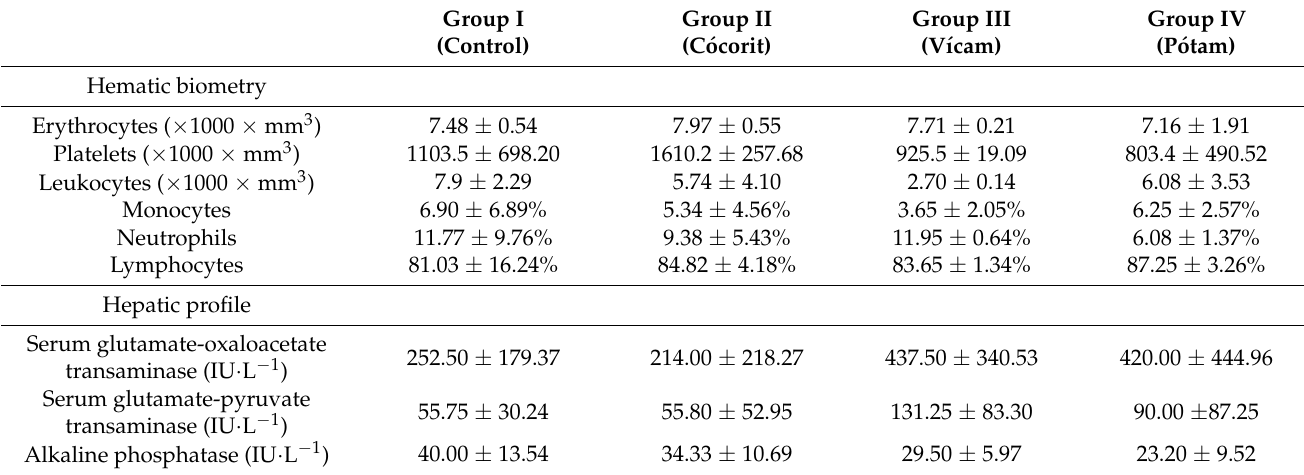
Table 3. Hematological and biochemical results from sacrificed mice at the end of the experiment. No statistically significant changes were